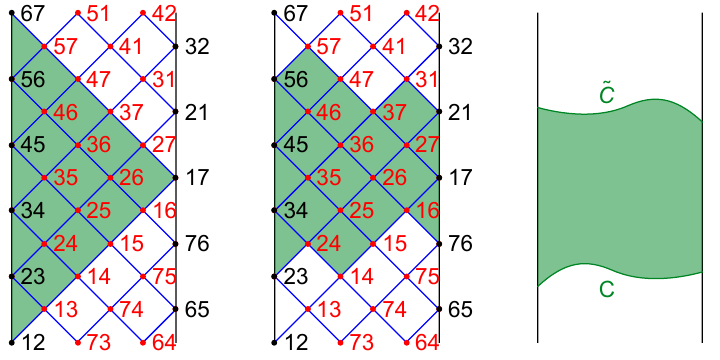
Figure 4 . Examples of minimal non-redundant